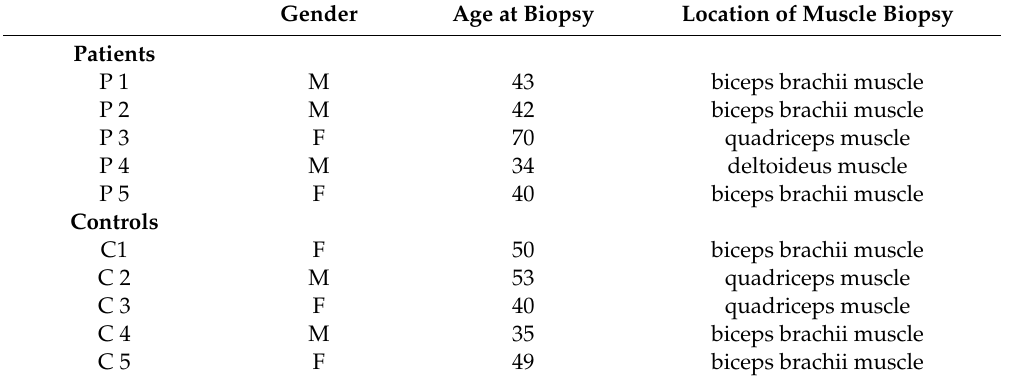
Table 1. Sex, age, and location of muscle biopsy of five patients with the genetically confirmed m.3243A > G mutation and five healthy controls, F: female, M: